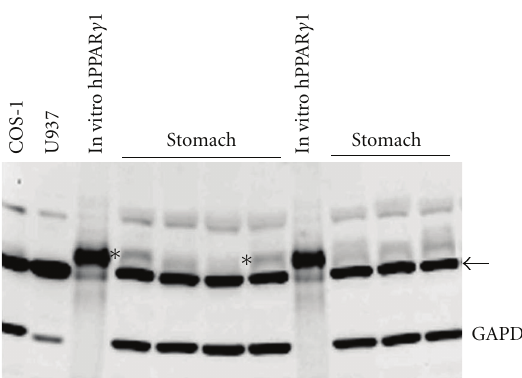
Figure 1: Western blot showing the comparison of banding patterns in COS-1 cell lysate, U937 cell lysate, in vitro translated human PPAR γ 1, and tissue lysate from human fetal stomach samples. The ∼ 55 kD band of human PPAR γ 1 and corresponding band in stomach tissue lysate is marked with an asterisk ( ∗ ). The nonspecific, cytoplasmic actin band is marked with an